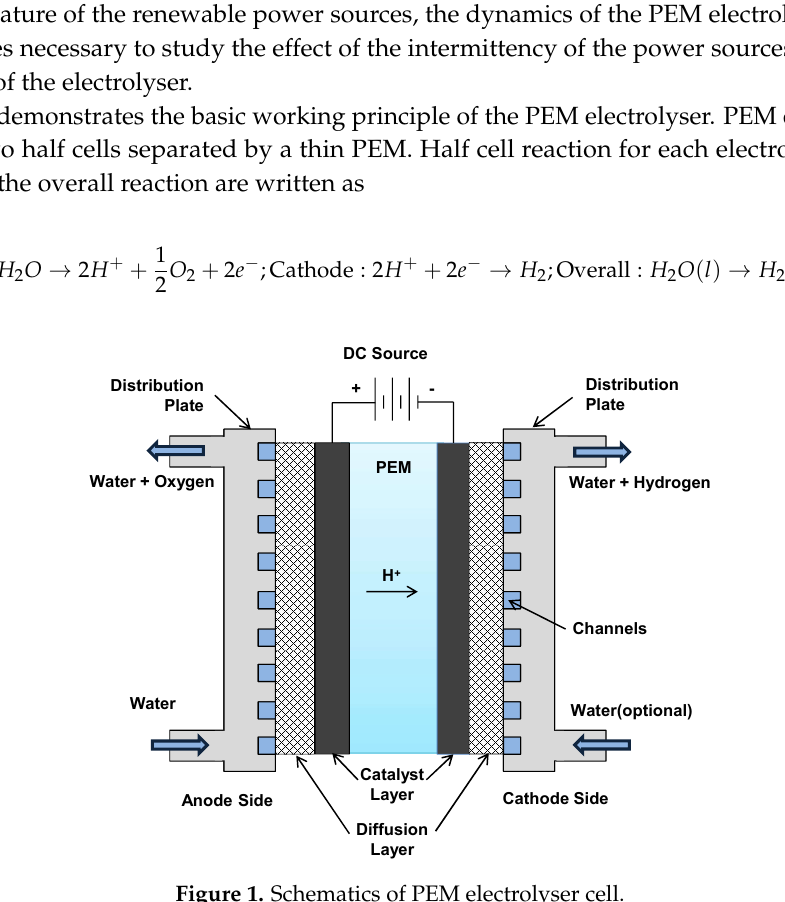
Figure 1. Schematics of PEM electrolyser